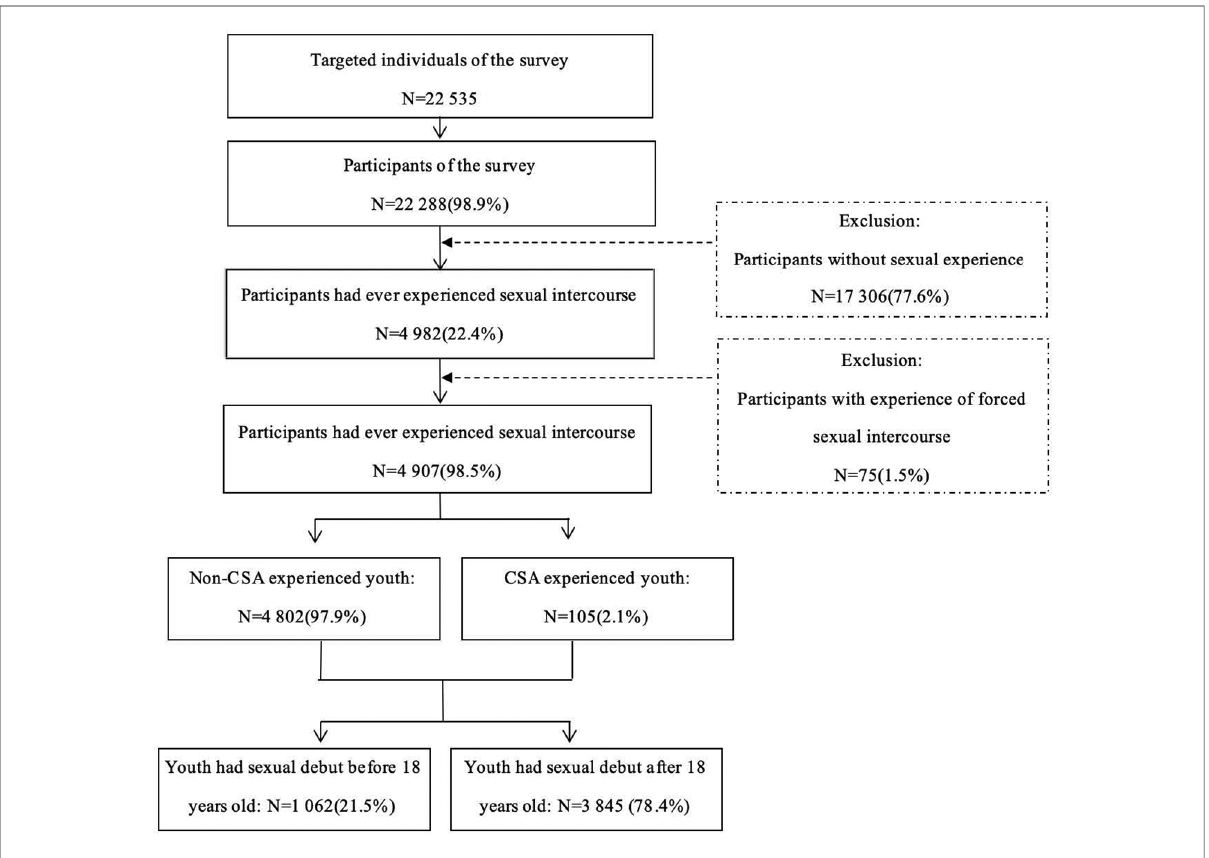
FIGURE 1 Flowchart of the study